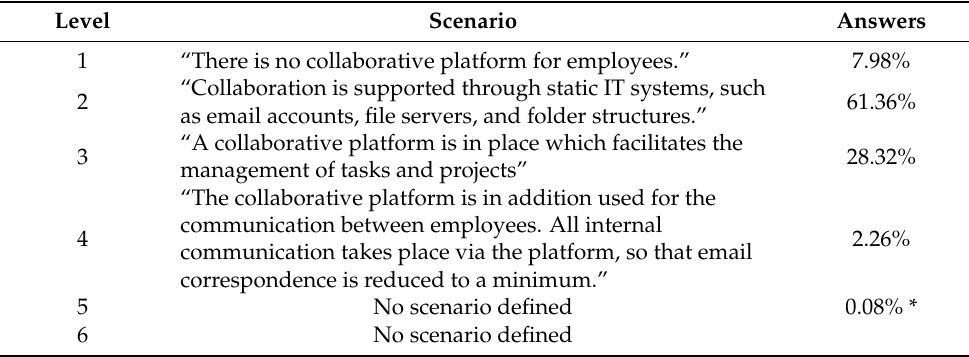
Table 4. Results for the capability “Collaboration in